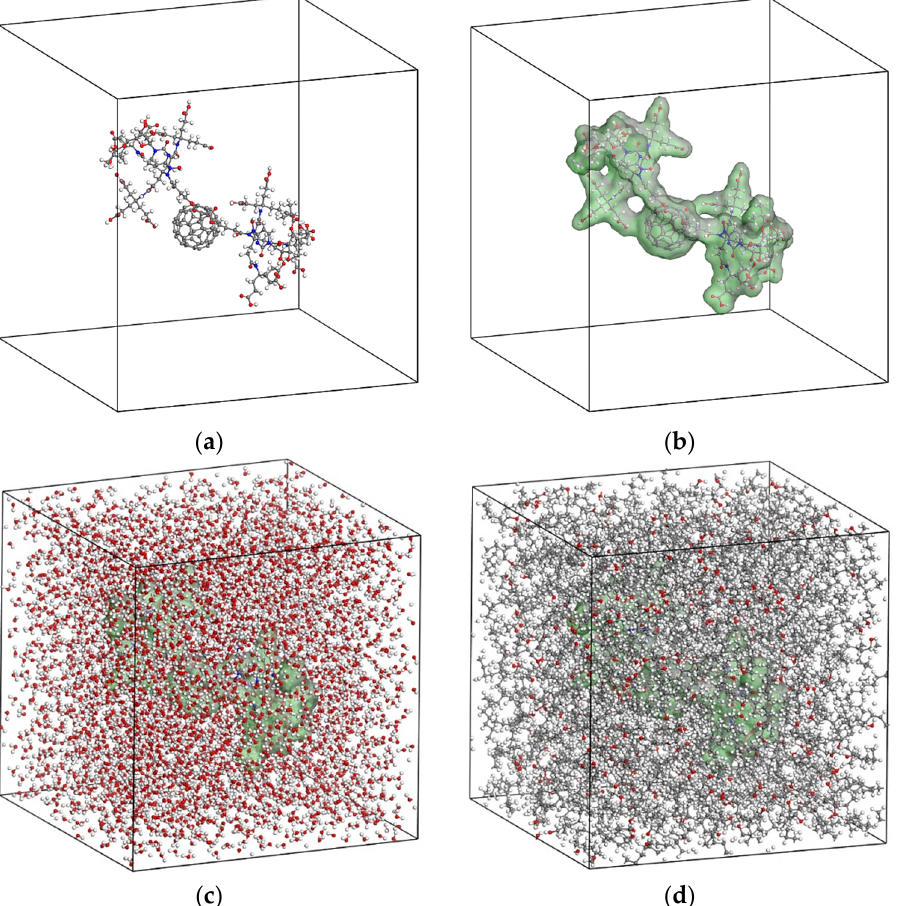
Figure 8. The unit cell for simulating the dendro[60]fullerene/molnupiravir drug delivery system as a solute: ( a ) Solute central position, ( b ) solute Connolly surface, ( c ) solute in water solvent, and ( d ) solute in n-octanol solvent.